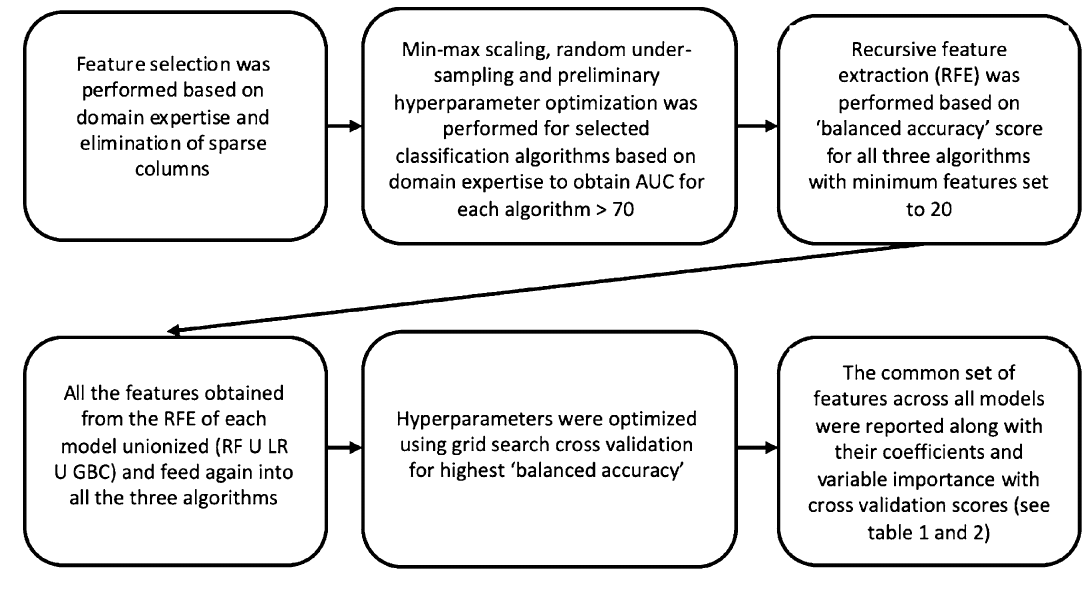
Figure 1. Machine learning pipeline for obtaining KPI’s.